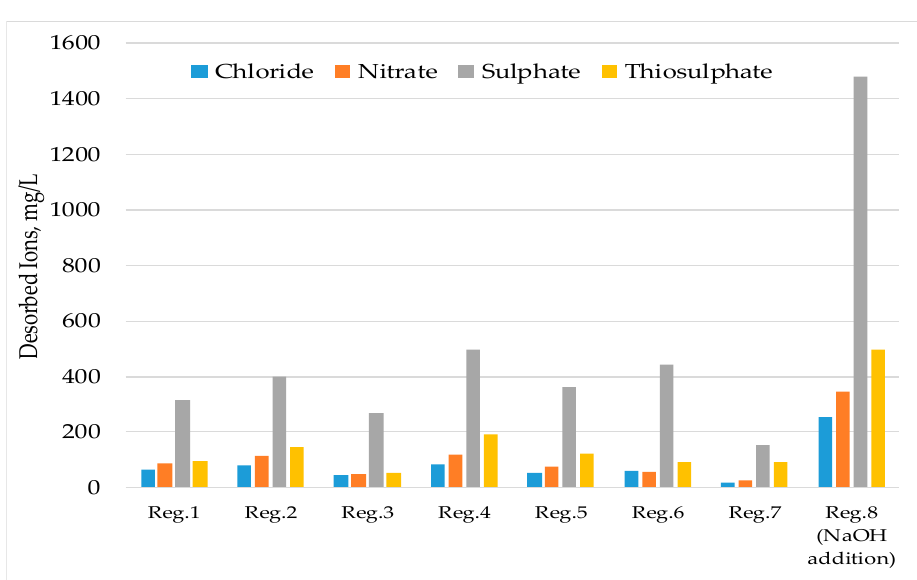
Figure 9. Regeneration of the resin using the same regenerant (4% w/v NaOH solution).